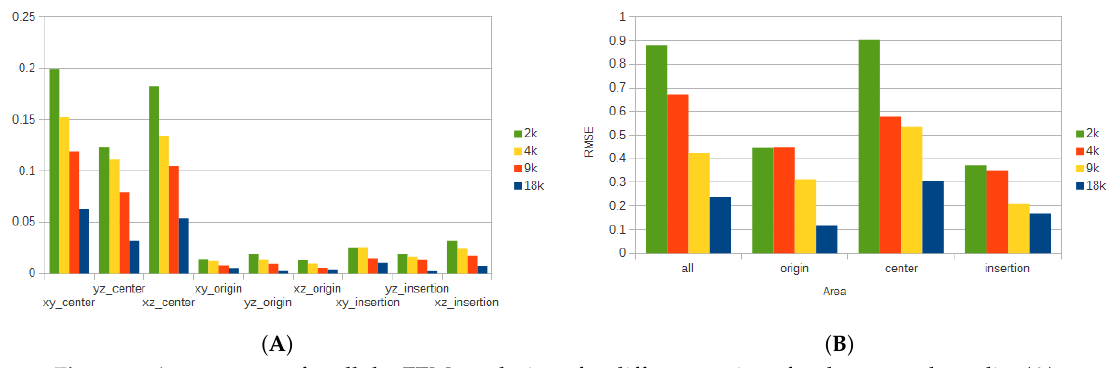
Figure 9. Average error for all the FEM resolutions for different regions for the vastus lateralis. ( A ) shows the average displacement error for all particle resolutions. ( B ) shows the average pressure error for all particle